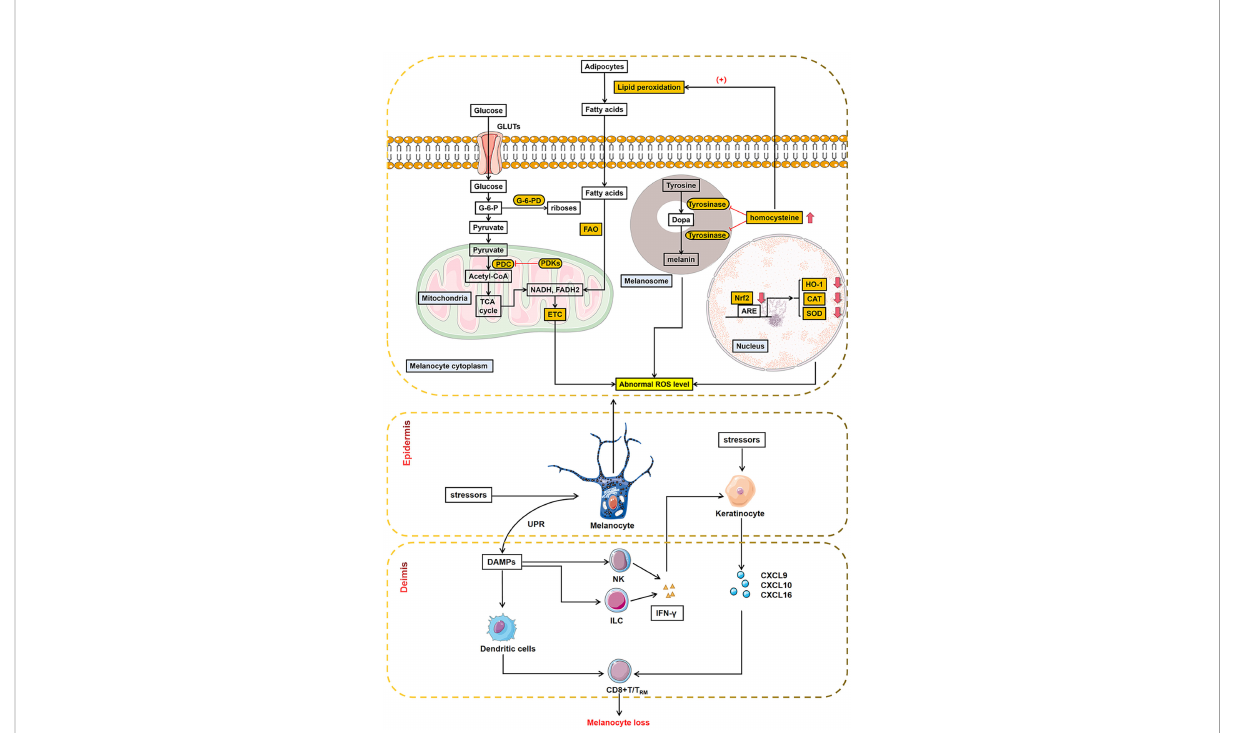
FIGURE 1 Abnormal metabolic processes in melanocytes during oxidative stress. Oxidative stress triggered abnormal glycolipid metabolism within melanocytes, disrupting metabolic pathways. Melanocytes with mitochondrial disorders, abnormal melanin biosynthesis, and dysregulated metabolic pathway produce abnormal ROS, exacerbating oxidative stress. The orange-boxed portion of the fi gure shows outlier segments,